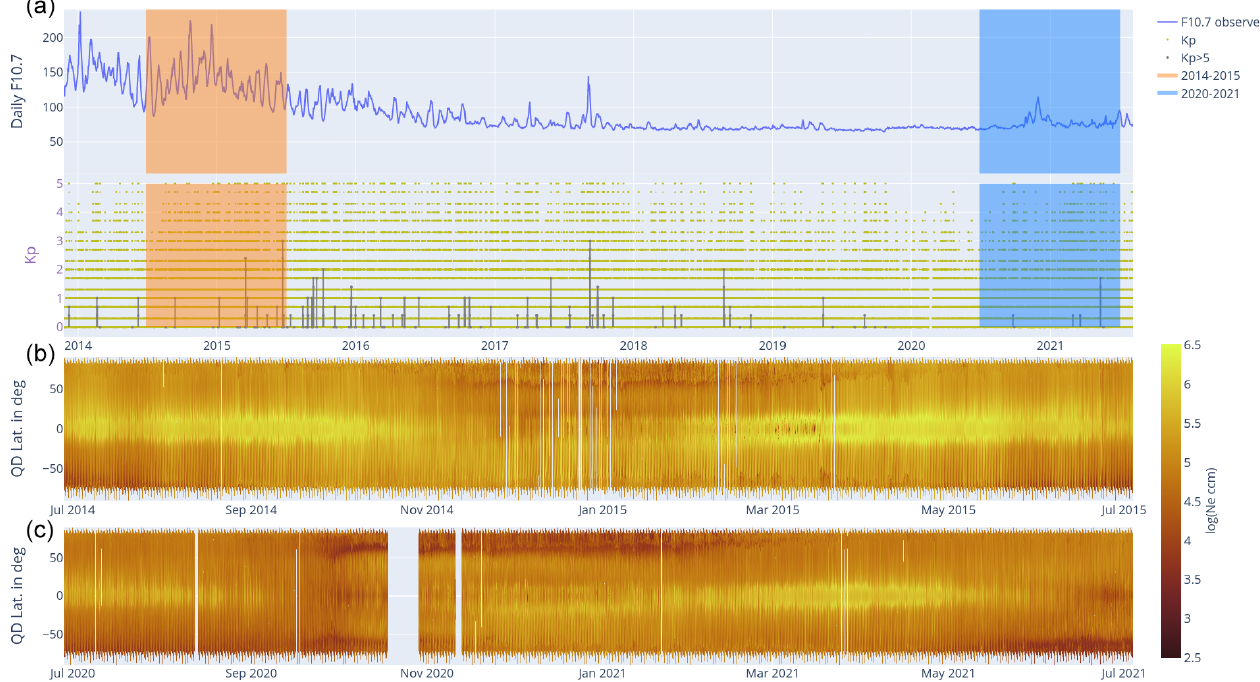
Figure 5. Overview of F10.7cm and Kp indices over the ≈ 7 years of Swarm in orbit. The top panel (a) shows the 10.7cm radio flux; the panel below (b) shows the Kp index. The bottom panels (c) show, with a logarithmic colour scale, the plasma density measured by Swarm A in ascending orbits for two representative time intervals of 1-year duration, July 2014–June 2015 and July 2020–July 2021. Time is on the x axis; the quasi-dipole latitude is on the y axis. The highest densities occur typically near the magnetic Equator on the day side, associated with the equatorial ionization anomaly. Very low densities are typically seen in the night-side midlatitude trough and around the winter polar